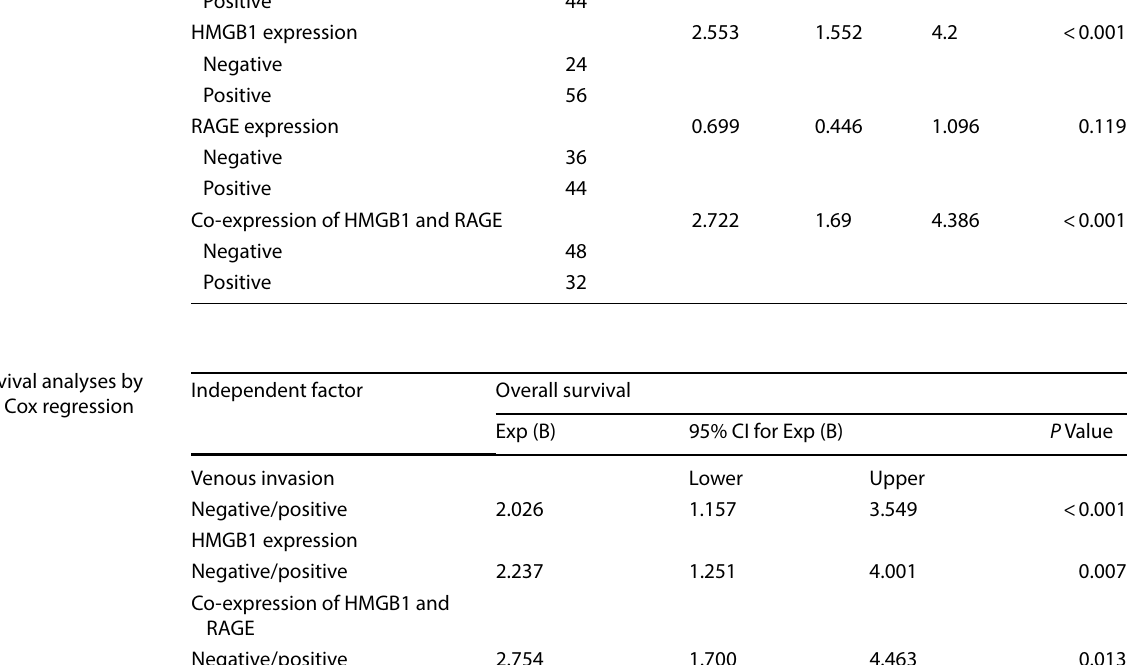
Table 6 Cox regression survival analysis of factors predicting survival time of patients with ESCC